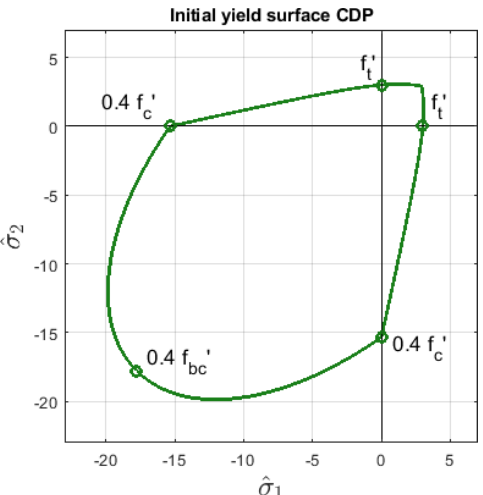
Figure 2. Initial yield surface F p = 3 MPa, f c = 38.3 MPa, f (cid:48) f (cid:48) t